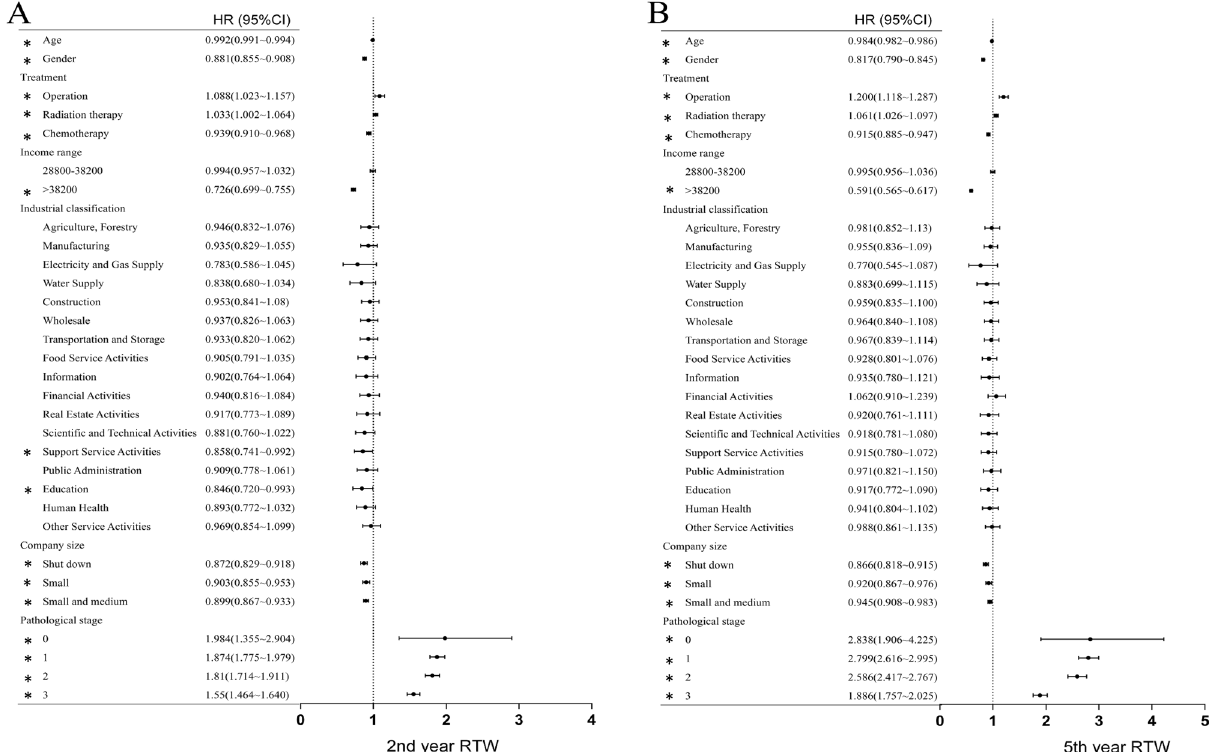
Figure 3. Multivariate association between independent variables and RTW in the 2nd and 5th